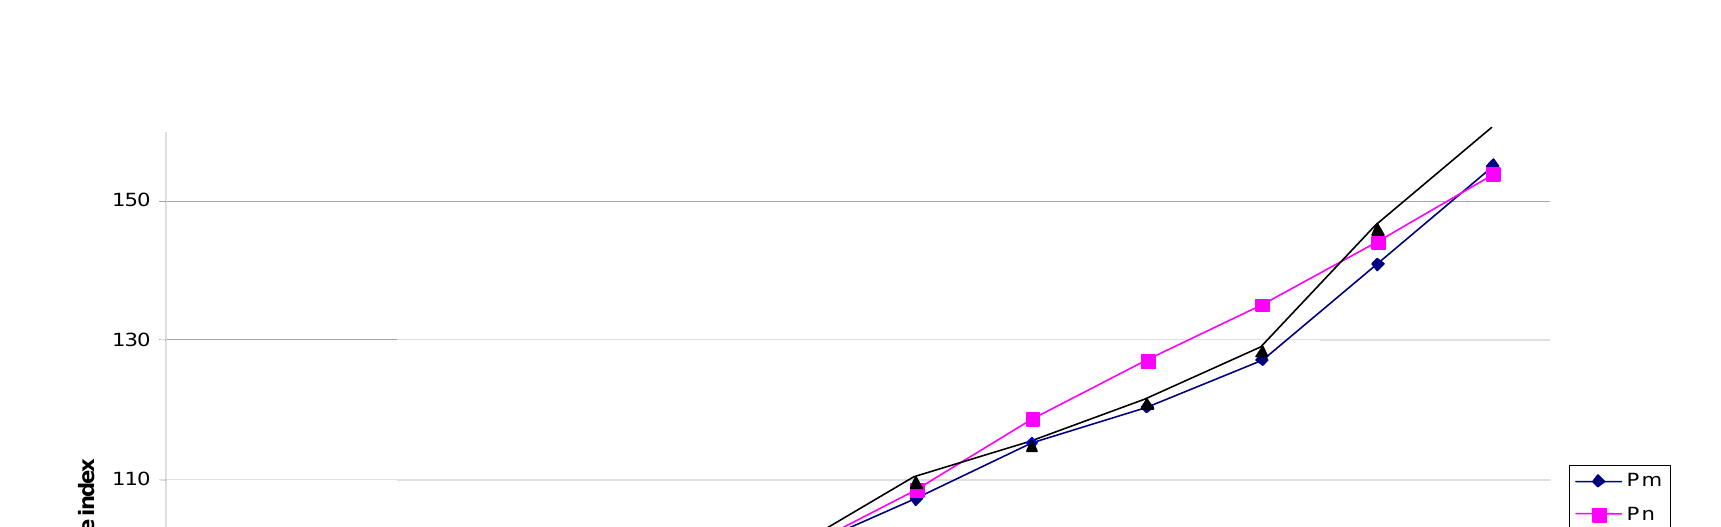
Figure 1 Price of exportables, importables and